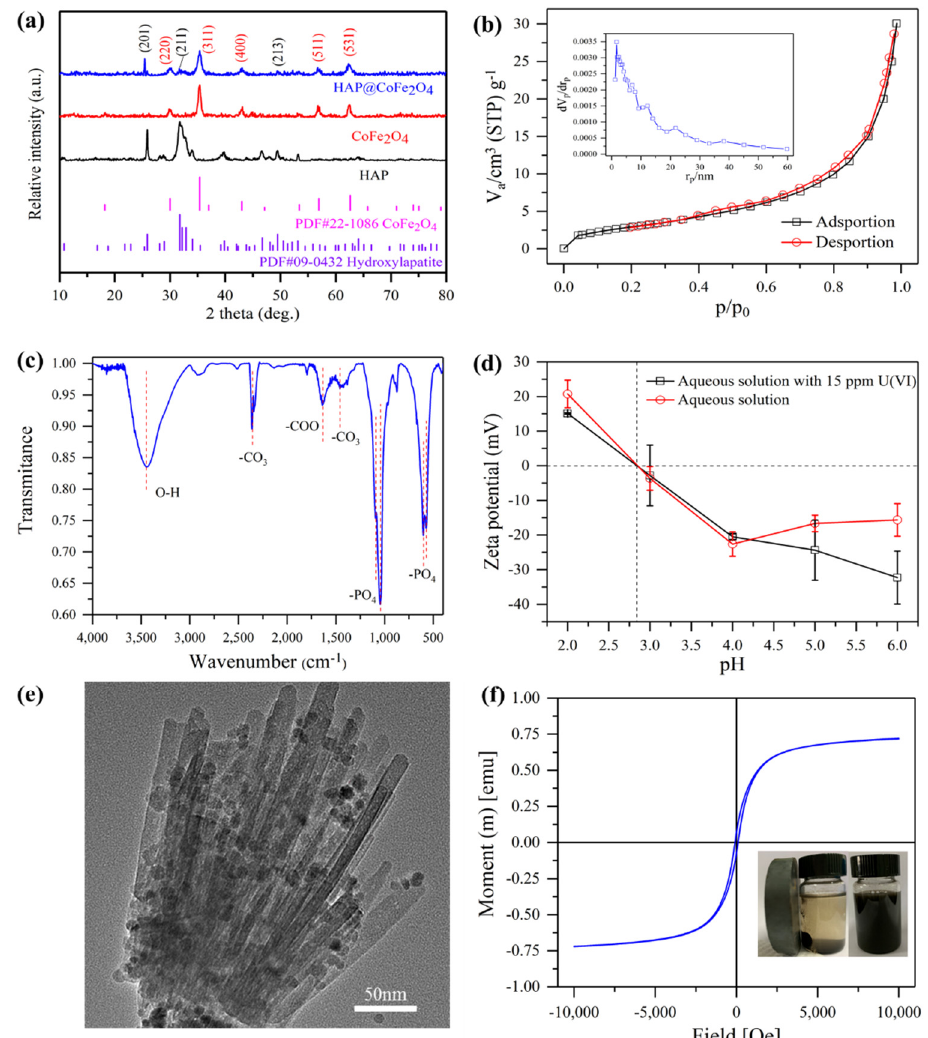
Figure 1. XRD patterns ( a ) of HAP, CoFe 2 O 4 as well as HAP@CoFe 2 O 4 , ( b ) the nitrogen adsorption-desorption isotherm (calculated from the Brunauer–Emmett–Teller [BET method] and pore size distribution (calculated from the BJH method), ( c ) Fourier transform infrared [FT-IR] spectrum, ( d ) zeta-potential and ( e ) transmission electron microscopy (TEM) image, and ( f ) the hysteresis loop of HAP@CoFe 2 O 4 (inset of Figure 1f displays the separation of HAP@CoFe 2 O 4 with and without an additional magnet).